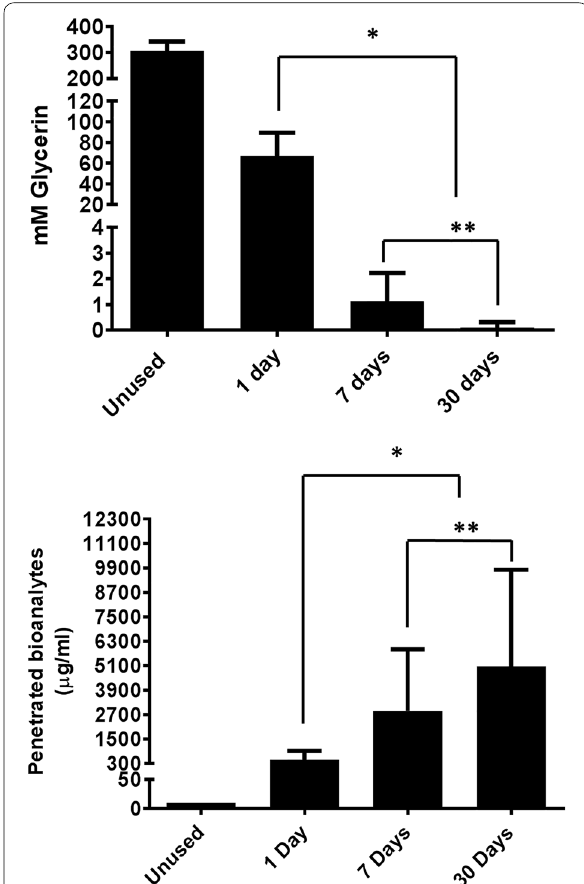
Fig. 4 Using objective markers to assess IVR use in the CONRAD 135 Study. Twenty women used one IVR per time point. Glycerin (top) and penetrated bioanalytes (bottom) were measured in separate extracts, each representing one-quarter of an IVR. Glycerin and bioanalytes levels were significantly different among all time points. N *p < 0.0001, 1 day vs. 7 and 30 days, **p < 0.0001, 7 days vs. 30